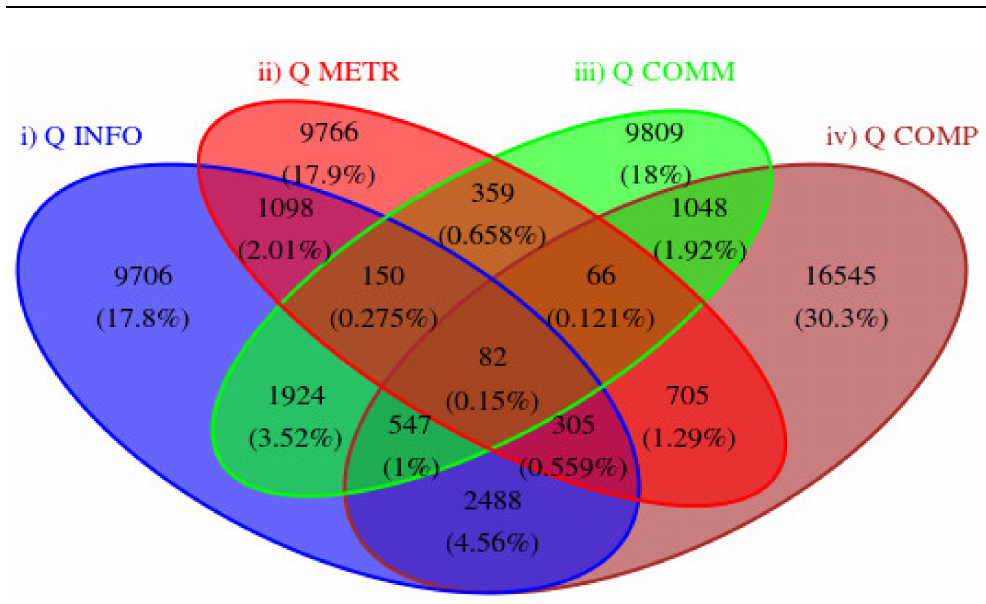
Figure 1. Venn diagram of mutual overlaps of the four fields of QT